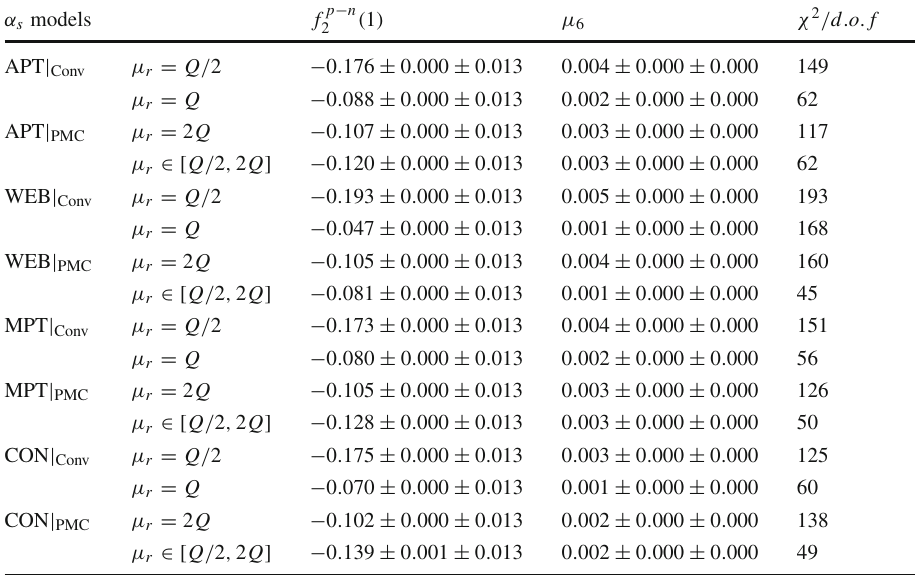
Table 1 The fitted parameters − n ( Q 2 = 1 GeV 2 ) and μ f p 2